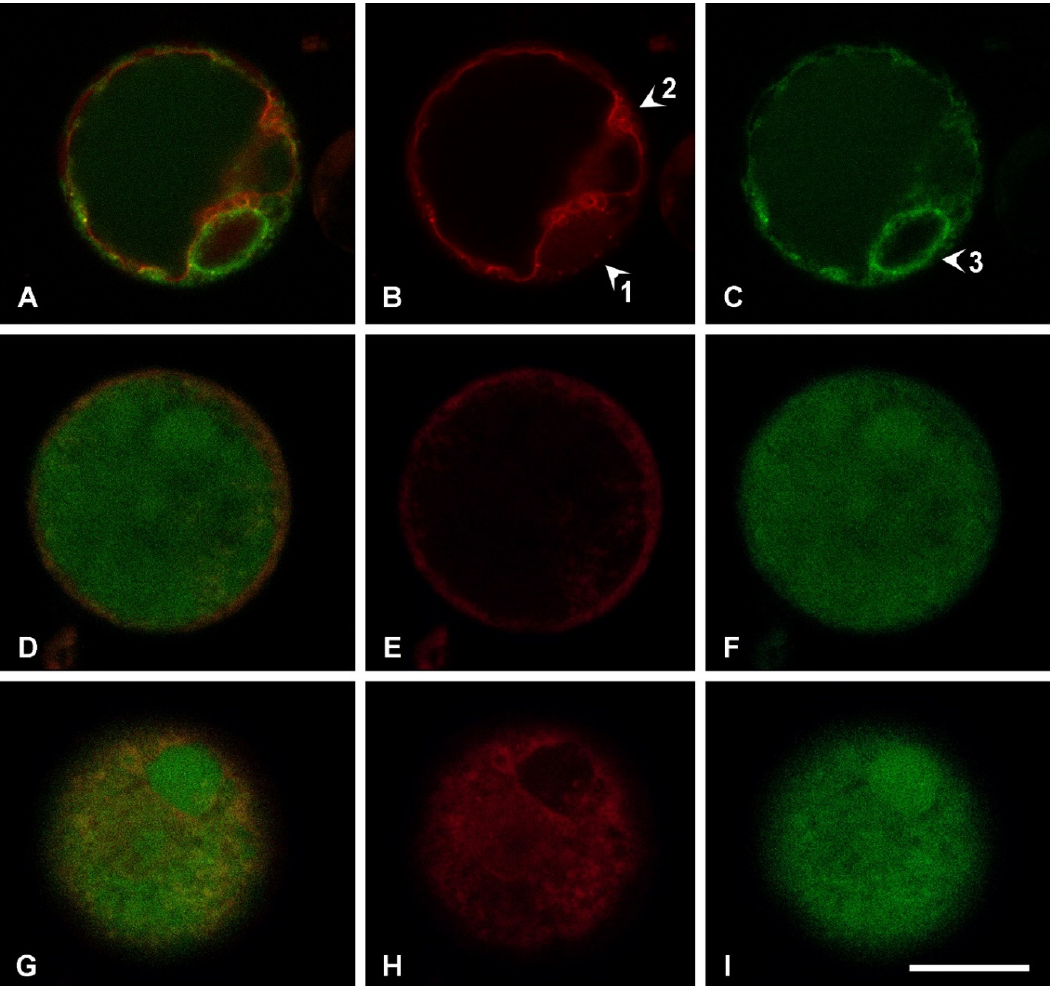
Figure 4. Protoplasts transiently transformed with vacuolar markers. ( A ) Protoplast expressing RFP-SYP51 and GFPgl133Chi; ( B ) the red RFP-SYP51 signal allows to appreciate tonoplast but also Trans Golgi Network (TGN) (arrow 1) and small vacuoles in the proximity of the central one (arrow 2); ( C ) the green GFPgl133Chi signal is distributed between the Endoplasmic Reticulum (ER) and the central vacuole, the nuclear ring is also well visible (arrow 3). ( D ) Equatorial optical section of a protoplast expressing AleuRFP and GFPgl133Chi; ( E ) the red AleuRFP signal is not efficiently labeling the central vacuole; ( F ) the green GFPgl133Chi signal is completely in the central vacuole. ( G – I ) Polar optical section of the same protoplast shown in D–F and confirming the same distribution of fluorophores. Scale bar 20 µm.